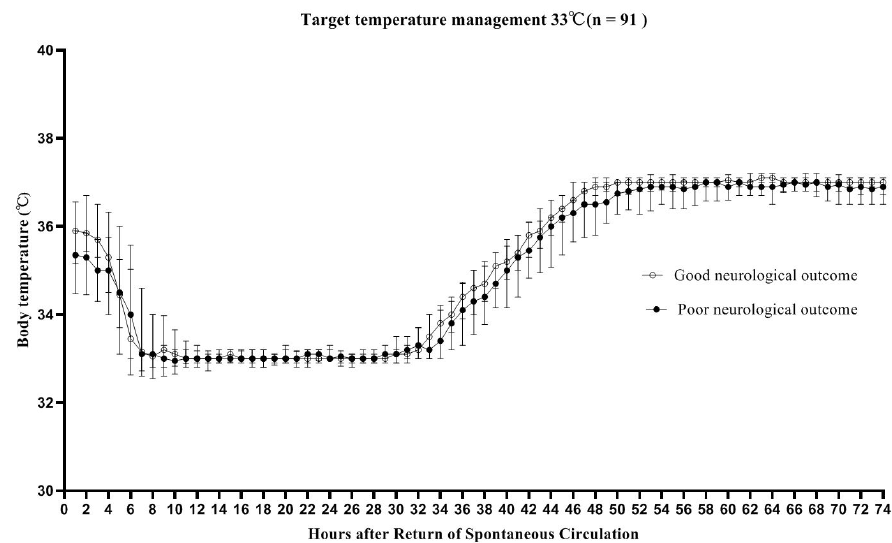
Figure 1. Target temperature management, 33 °C ( n = 91). The ┬ bars indicate the interquartile ranges of the good and poor outcome groups. The target temperature of both groups was 33 °C (32–34 °C), and the duration of cooling was 24 h. Upon completion of the targeted temperature management (TTM) cooling period, the patients were rewarmed to 37 °C at a rate of 0.25 °C/h. Only patients with recorded temperatures were included in the analysis.